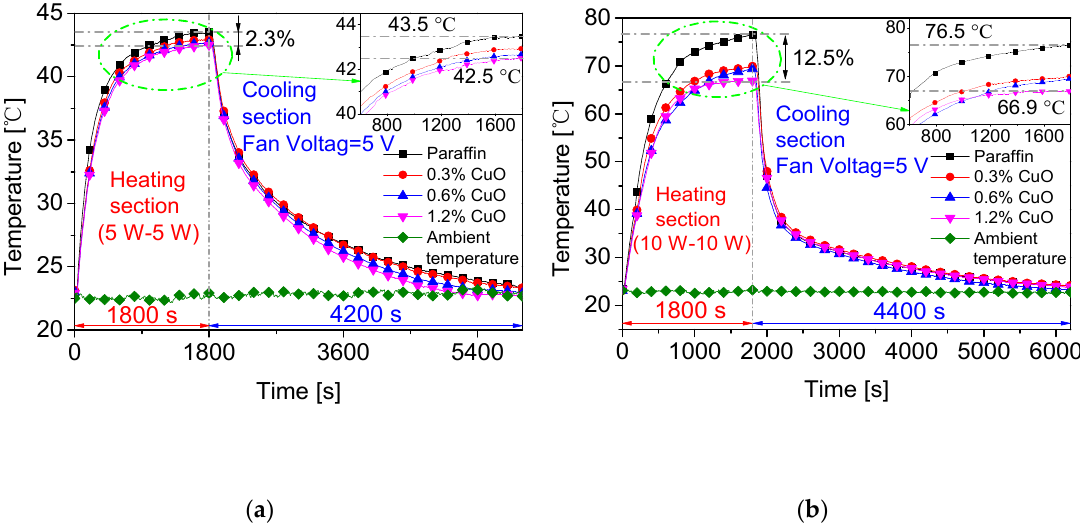
Figure 4. Temperature variations on the evaporator with phase-change materials at the heating power of ( a ) 5 W–5 W and ( b ) 10 W–10 W.